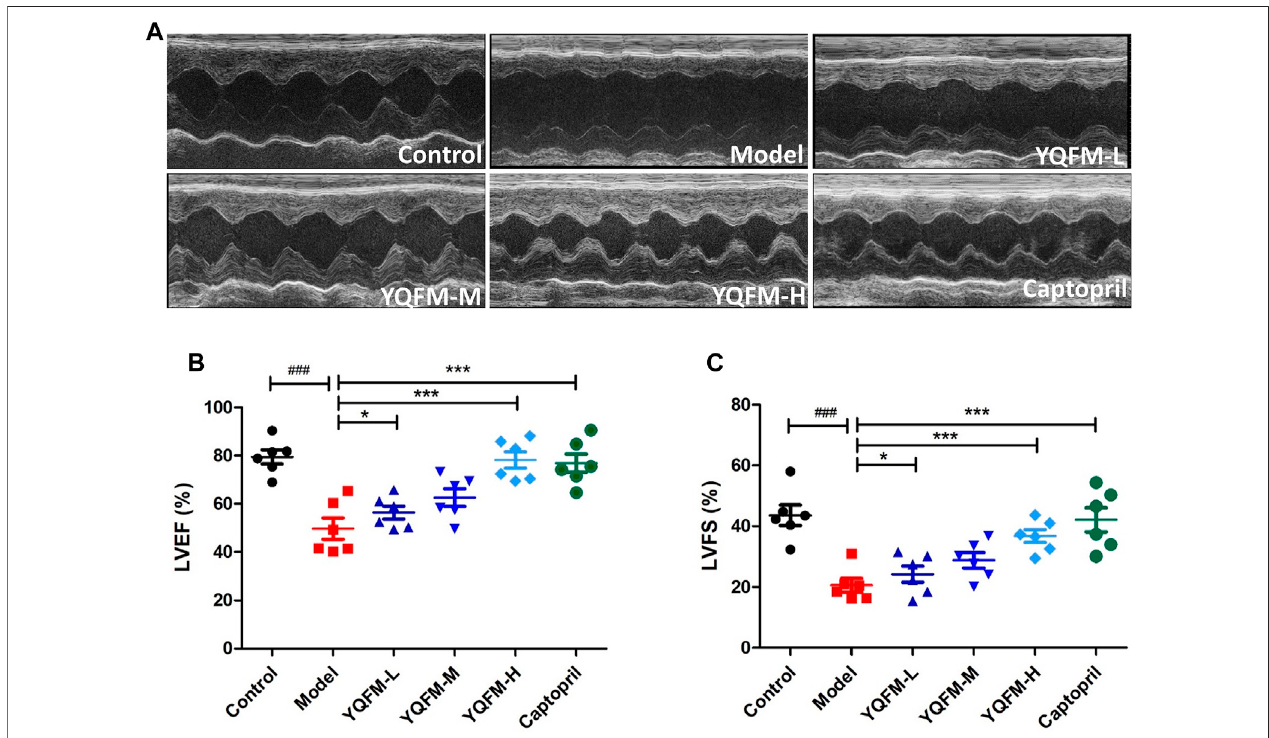
FIGURE2| TheeffectofYQFMoncardiacfunctioninCHFratafterbeingtreatedfor28 days. (A) Representativeechocardiographfromthevariousgroups. (B) Left ventricle ejection fraction (LVEF) ( n (cid:2) 6 animals/group). (C) Left ventricle fractional shortening (LVFS) ( n (cid:2) 6 animals/group). Data are means ± SD. # p < 0.05, ## p < 0.01, ### p < 0.001 vs the Control group, * p < 0.05, ** p < 0.01, *** p < 0.001 vs the Model